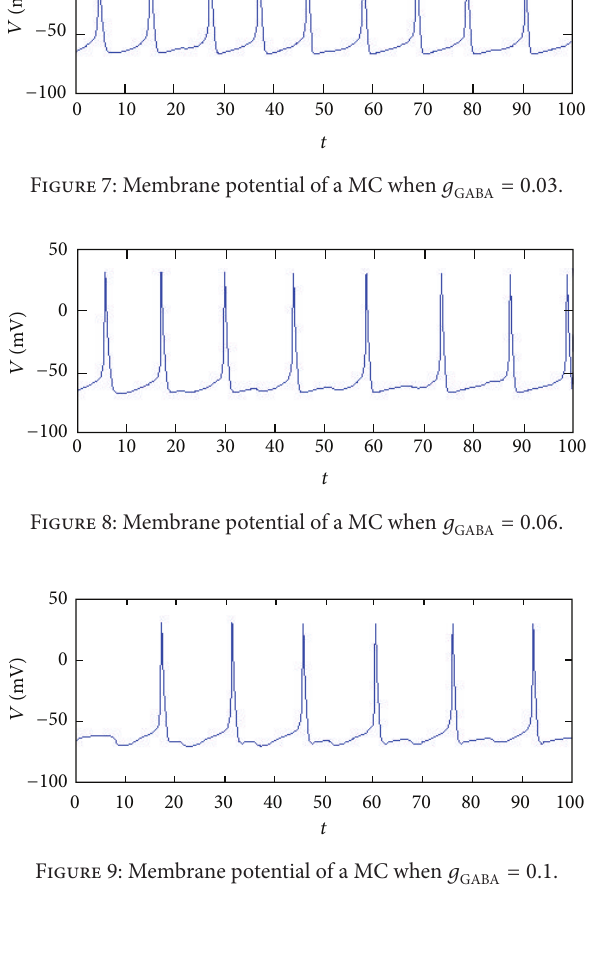
Figure 9: Membrane potential of a MC when 𝑔